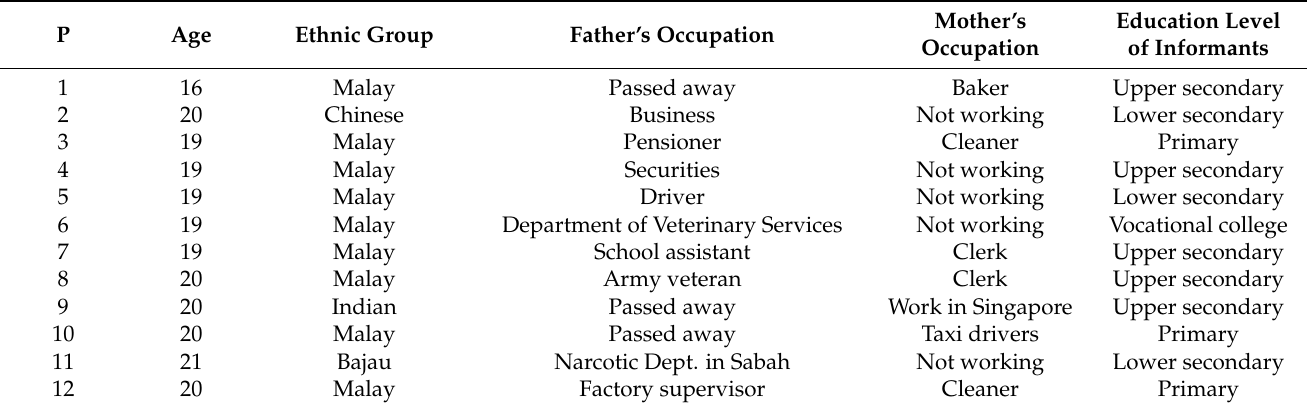
Table 1. Participant Background